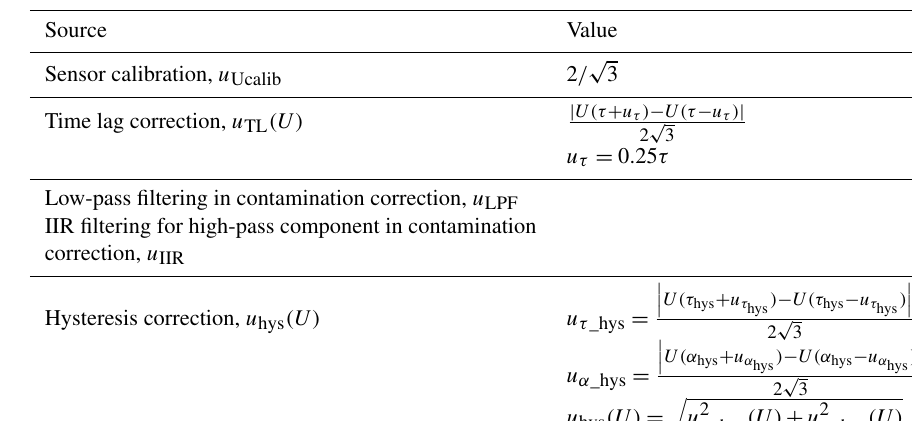
Table 5. Sources contributing to iMS-100 relative humidity measurement